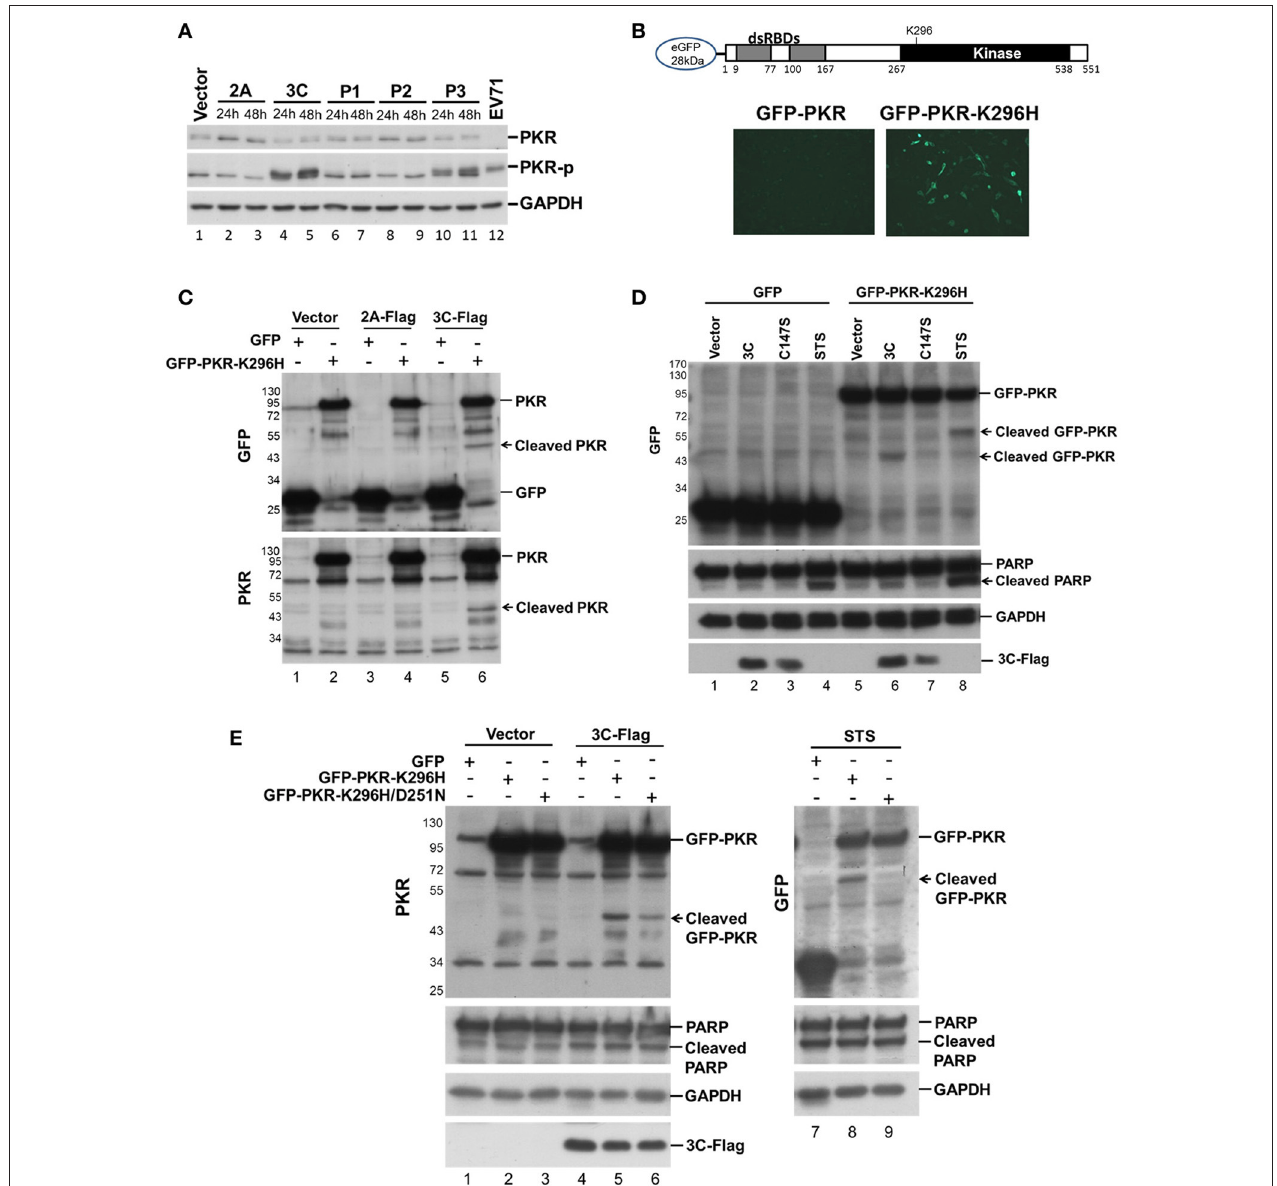
FIGURE 2 | Viral 3C protease is related to the cleavage of recombinant PKR. (A) Plasmids expressing viral 2A, 3C, P1, P2, and P3 were transfected into RD cells for 24 and 48 h. Equivalent amounts of protein from the cellular extracts were analyzed by immunoblotting using anti-PKR, PKR-p, and anti-GAPDH specific antibodies. An EV-A71-infected cellular extract served as a positive control. A representative result from three independent experiments is shown. (B) Schematic structure of the recombinant PKR, which has an N-terminal-linked GFP to allow monitoring of the cleavage product. RD cells were transfected with GFP-PKR or GFP-PKR-K296H for 24 h and the GFP expression was monitored using an EVOS fluorescence cell imaging system. (C) Plasmids expressing GFP-PKR-K296H were transfected into 293T cells for 24 h which were then transfected with the plasmid encoding 2A-Flag or 3C-Flag for another 24 h. Cell extracts were collected for immunoblotting using anti-GFP and anti-PKR antibodies. (D) A comparison of the cleavage patterns for 3C- and STS-induced PKR proteolysis. The 293T cells were transfected with GFP or GFP-PKR-K296H for 24 h and were then transfected with either empty vector, 3C-Flag, or C147S for another 24 h, or treated with STS for 8 h. Cell extracts were analyzed by immunoblotting using anti-GFP, anti-PARP, anti-GAPDH, and anti-Flag antibodies. A representative result from at least three reproducible experiments is shown. (E) Viral 3C cleaves PKR at a site that differs from that of apoptosis-induced PKR cleavage. The 293T cells were transfected with GFP, GFP-PKR-K296H, or GFP-PKR-K296H/D251N for 24 h, and were then transfected with either vector or 3C-Flag for another 24 h, or treated with STS for 8 h. The cell extracts were analyzed by immunoblotting using anti-PKR, anti-PARP, anti-GAPDH, and anti-Flag antibodies. A representative result from at least three reproducible experiments is